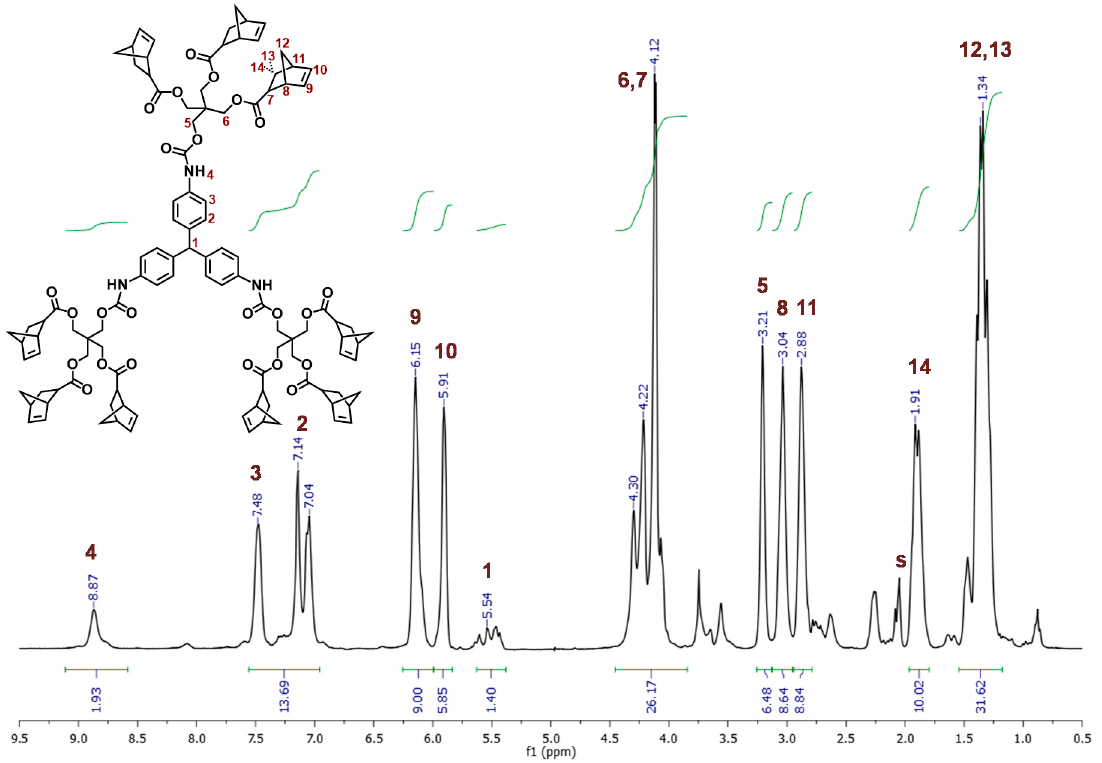
Figure 6. 1 H-NMR spectrum of aR-9-NBE in acetone-d 6 .